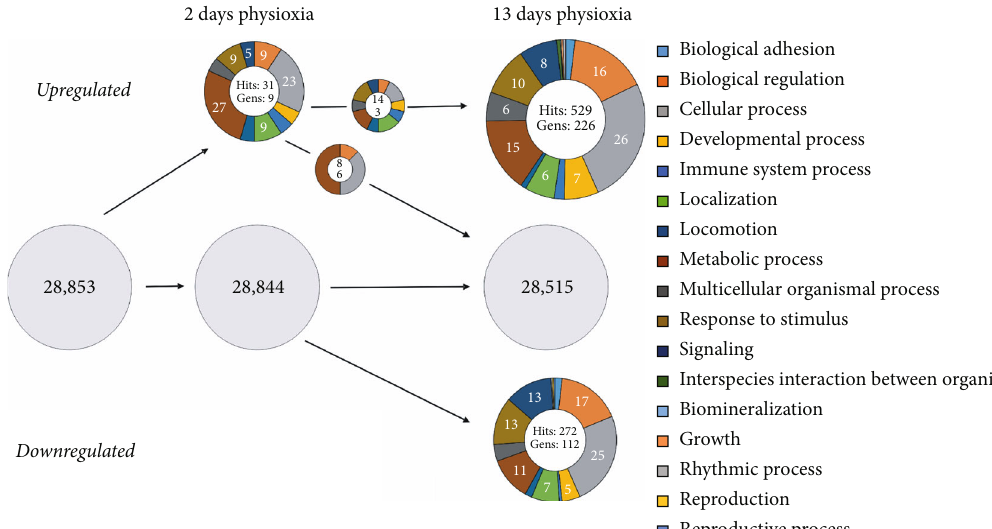
Figure 3: Global comparison of PANTHER gene categories “ biological process ” in midbrain NSC cultures. Displayed are percentages of hits from oxygen-regulated genes to speci fi c categories according to the PANTHER domain “ biological process. ” The PANTHER classi fi cation includes the total up-/downregulated genes (lower number in the inner circle) with at least a twofold di ff erence for short- and long-term cultures. The grey circles indicate all analysed genes without a change of expression due to O gene was downregulated in hypoxic cells, but 9 genes from di ff erent categories were upregulated, which formed a total of 31 hits. 3 genes and 14 hits of them were also upregulated in hypoxic prolonged cultures, while the other 6 genes did not undergo any O prolonged cultures. In total, 226 genes were upregulated and formed 529 hits, and 112 genes with 272 hits were downregulated after 13 days of hypoxic culture (13 d). The hits result from the multiple biological functions of a gene. Since a gene can also have multiple functions, one gene also often results in multiple hits. Also shown are the percentages of individual hits in the various biological functions (categories) to the total hits of the regulated